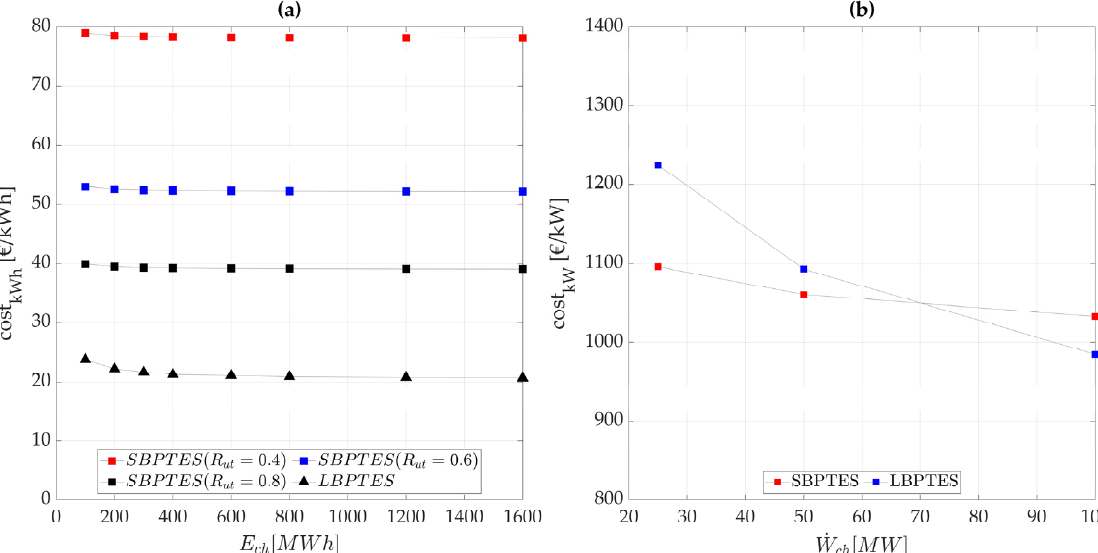
Figure 8. Comparison between the energy- and power-specific costs of LBPTES and SBPTES: ( a ) energy-specific cost in EUR/kWh of the equipment dedicated to energy storage; ( b ) power-specific cost in EUR/kW of the equipment dedicated to converting power into thermal exergy and vice versa. The results are related to nominal power ratings from 25 to 100 MW and nominal charge durations from 4 to 8 h . For the SBPTES, capacity utilisation ratios ( R ut ) equal to 0.4, 0.6 and 0.8 are reported.